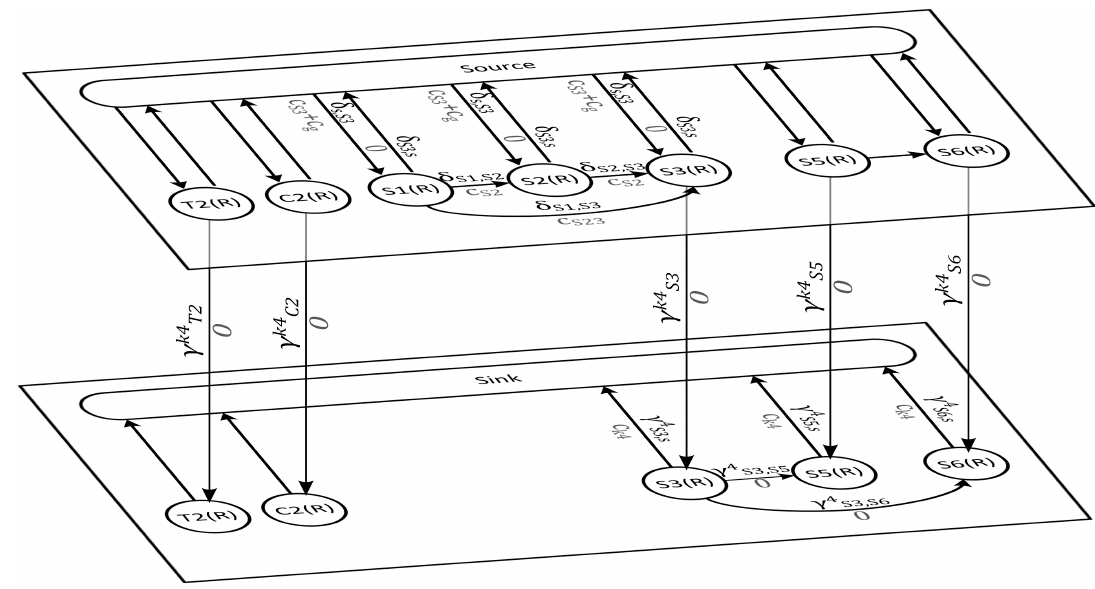
Figure 7. Illustration of network flow optimisation model.